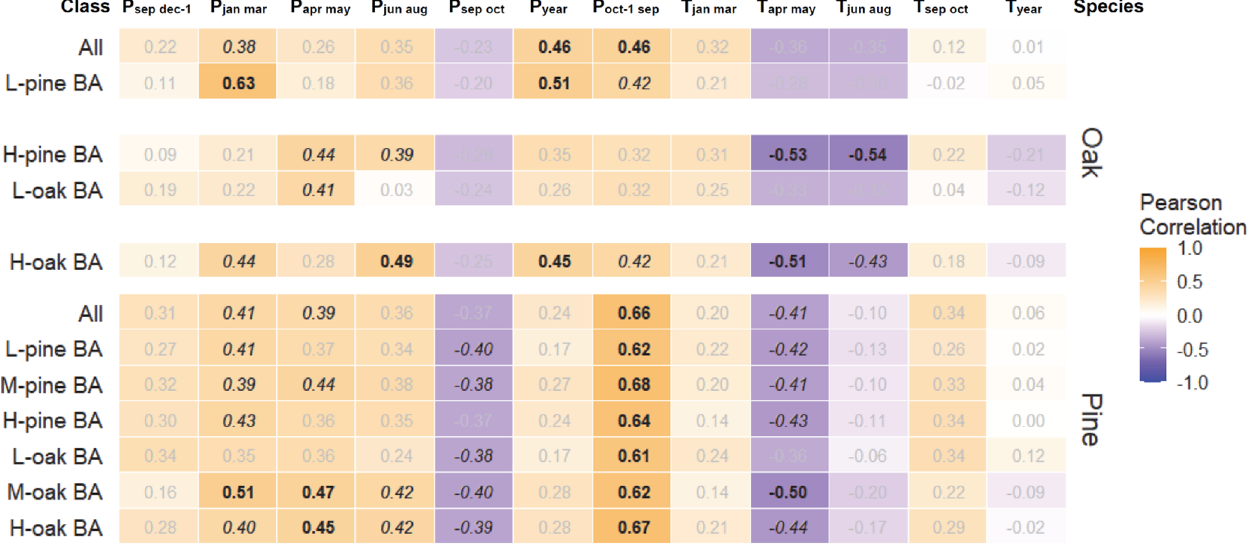
Figure 2. Simple (Pearson) correlation coefficients between linearly detrended time series of climate and indexed tree-ring chronologies (TRW) for the period 1994-2013. The relationships were evaluated for the whole stand (All) and for each local-density class, based on pine or oak local basal area (BA), as defined in Table 2. L, M, and H, low, medium, and high local density classes; P sep dec-1 , precipitation during previous-year autumn recharge; P jan mar , P apr may , P jun aug , P sep oct , and P year , winter, spring, summer, autumn, and total precipitation in current calendar year, respectively; P oct-1 sep , precipitation during the hydrological year; T jan mar , T apr may , T jun aug , T sep oct , and T year , spring, summer, autumn, and annual mean temperature in current calendar year. Correlations with p < 0.05 and p < 0.10 are highlighted in bold and italics, respectively.